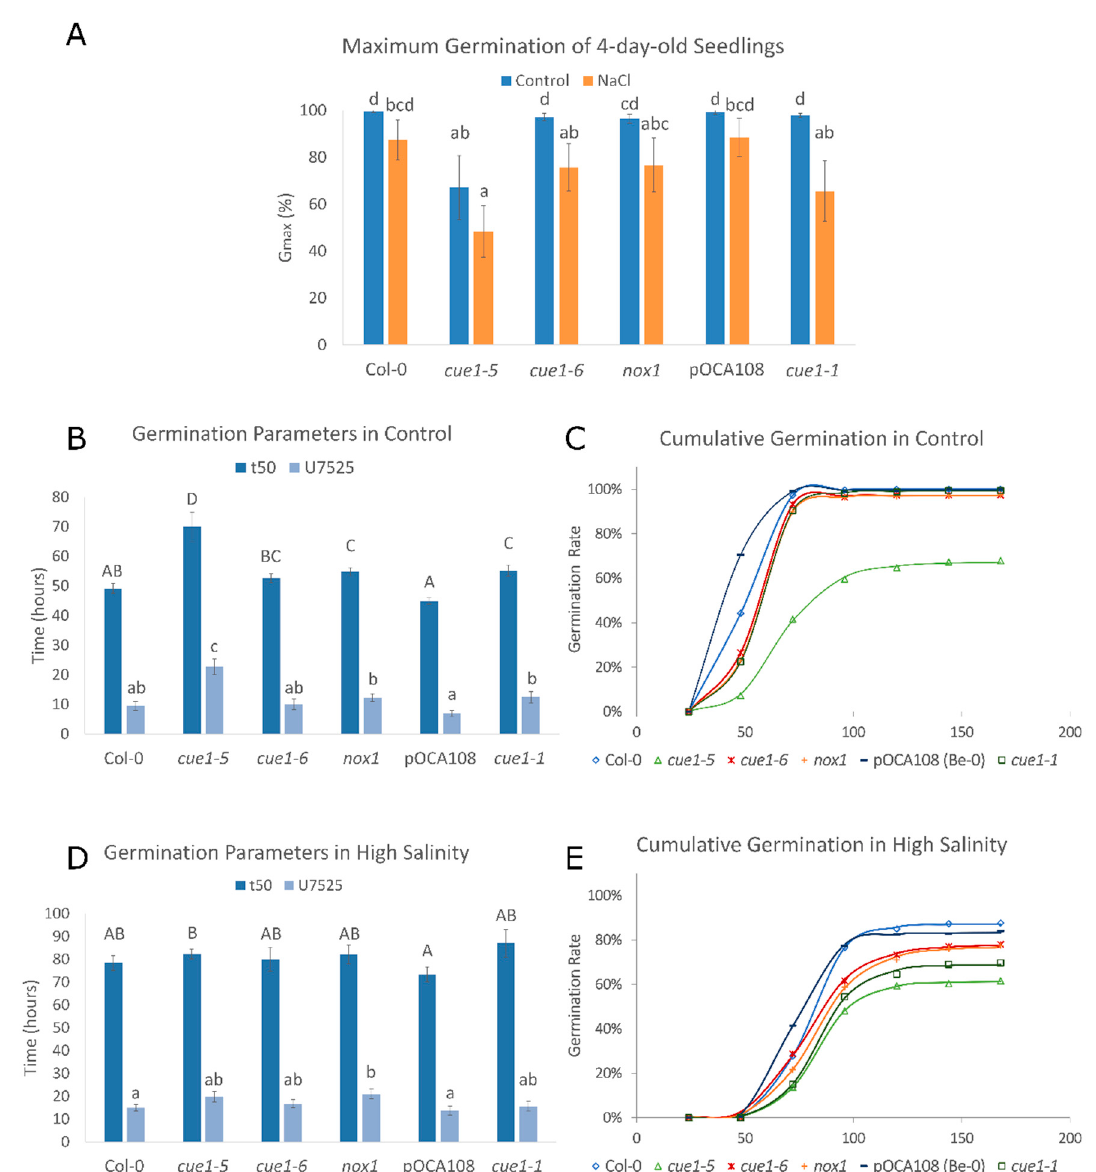
Figure 2. NO is required for germination vigor. Values represent the mean ± CI ( n = 12). Bars with common letters do not show significant statistical differences as determined by the respective statistical tests: ( A ) Maximum germination of seedlings 4 das with and without 100 mM NaCl. Welch’s one-way ANOVA with post-hoc Games–Howell test was F (5,29) = 7.98. p < 0.001. ( B ) Germination parameters t 50 and U 7525 for seeds germinated in control conditions. ( C ) Representative cumulative germination curve for seeds germinated in control conditions as predicted by GERMINATOR. ( D ) Germination parameters t 50 and U 7525 for seeds exposed to high salinity. ( E ) Representative cumulative germination curve for seeds germinated in the presence of 100 mM NaCl as predicted by GERMINATOR.